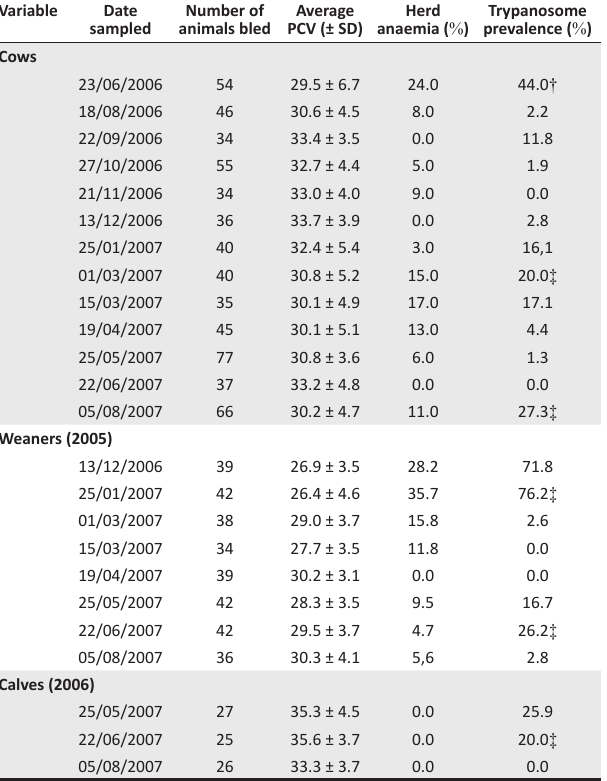
TABLE 1: Herd average packed cell volume, trypanosome prevalence, herd anaemia and treatment strategy in cattle from June 2006 to August 2007 at Boomerang